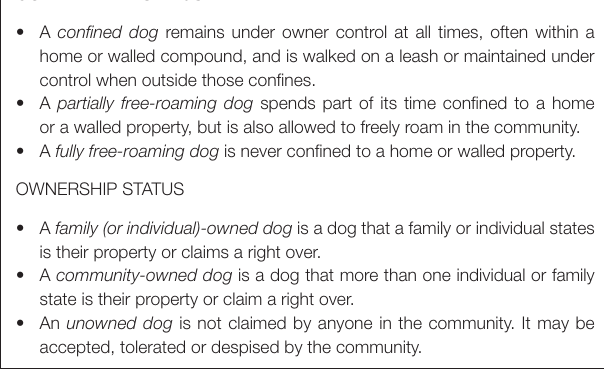
BOX 1 | Key characteristics of dog guardianship for DPM